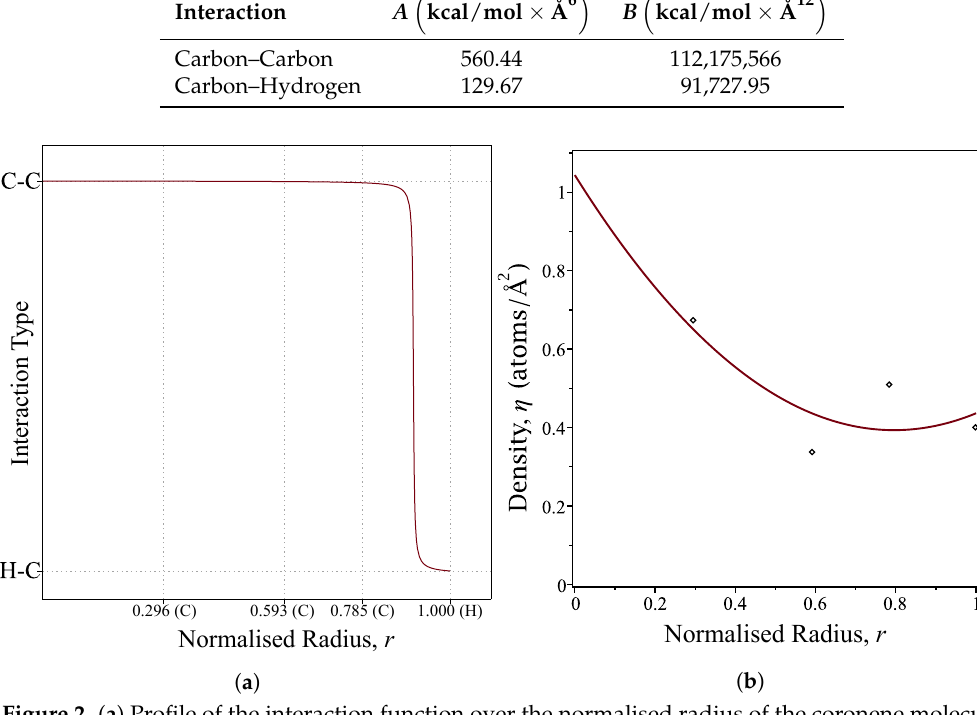
Figure 2. ( a ) Profile of the interaction function over the normalised radius of the coronene molecule where (C) and (H) denote the location of a carbon and hydrogen atoms, respectively; and ( b ) profile of the density function over the normalised radius of the coronene